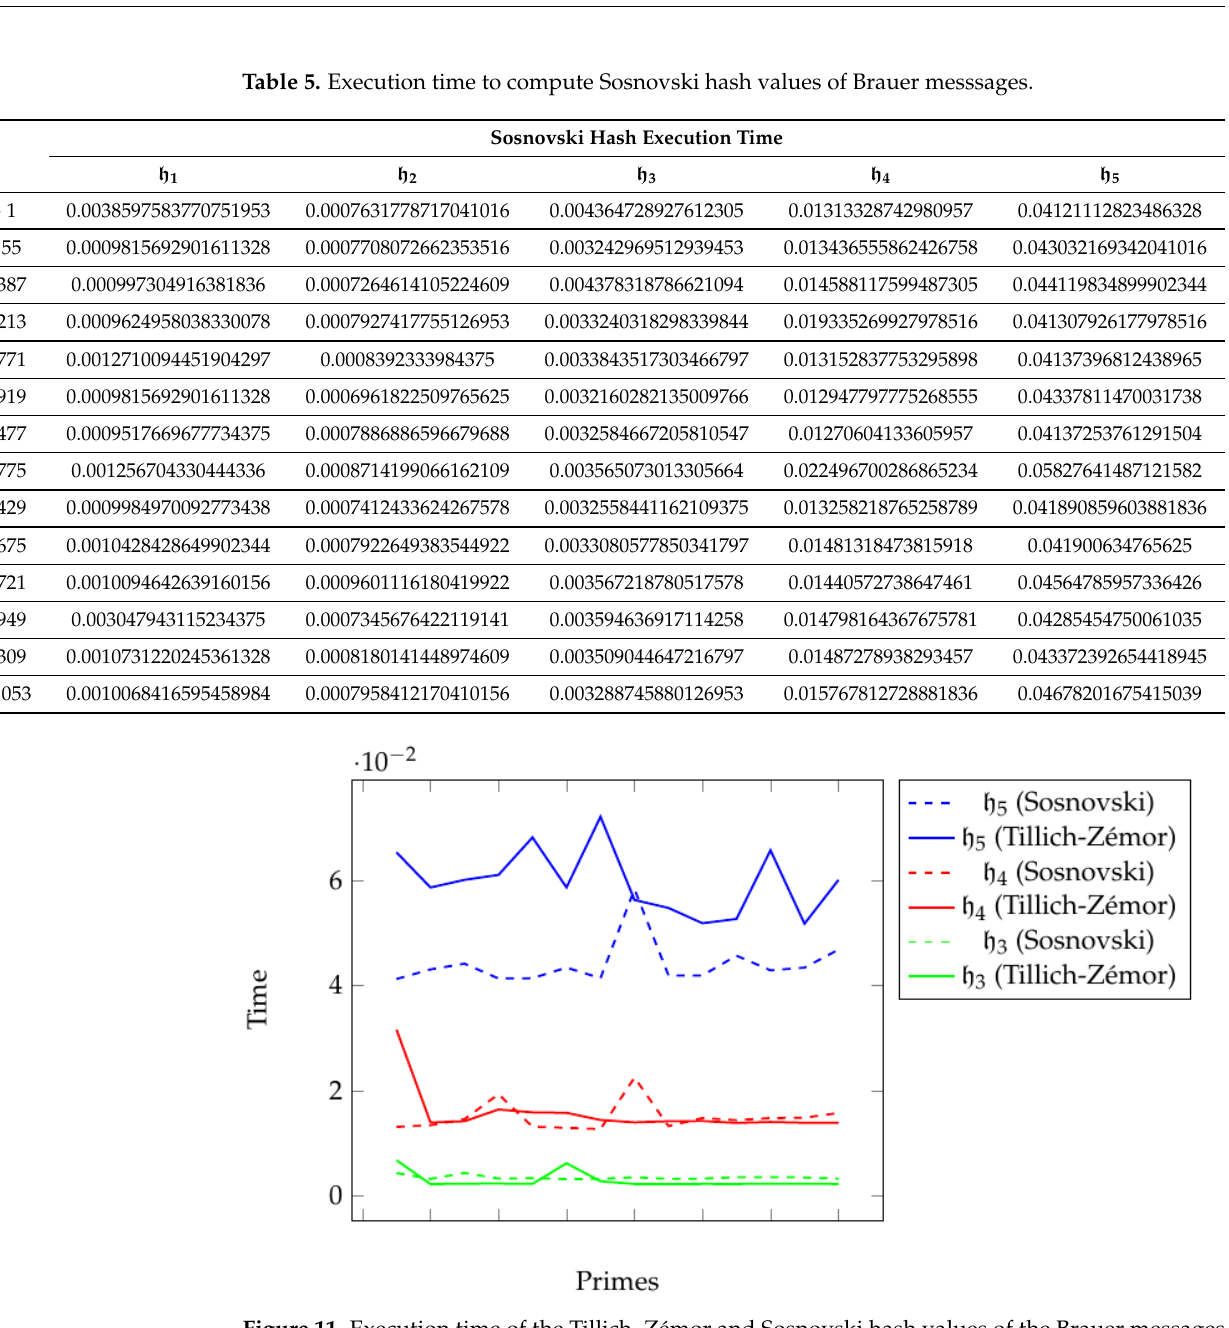
Figure 11. Execution time of the Tillich–Zémor and Sosnovski hash values of the Brauer messages h 3 h 5 −